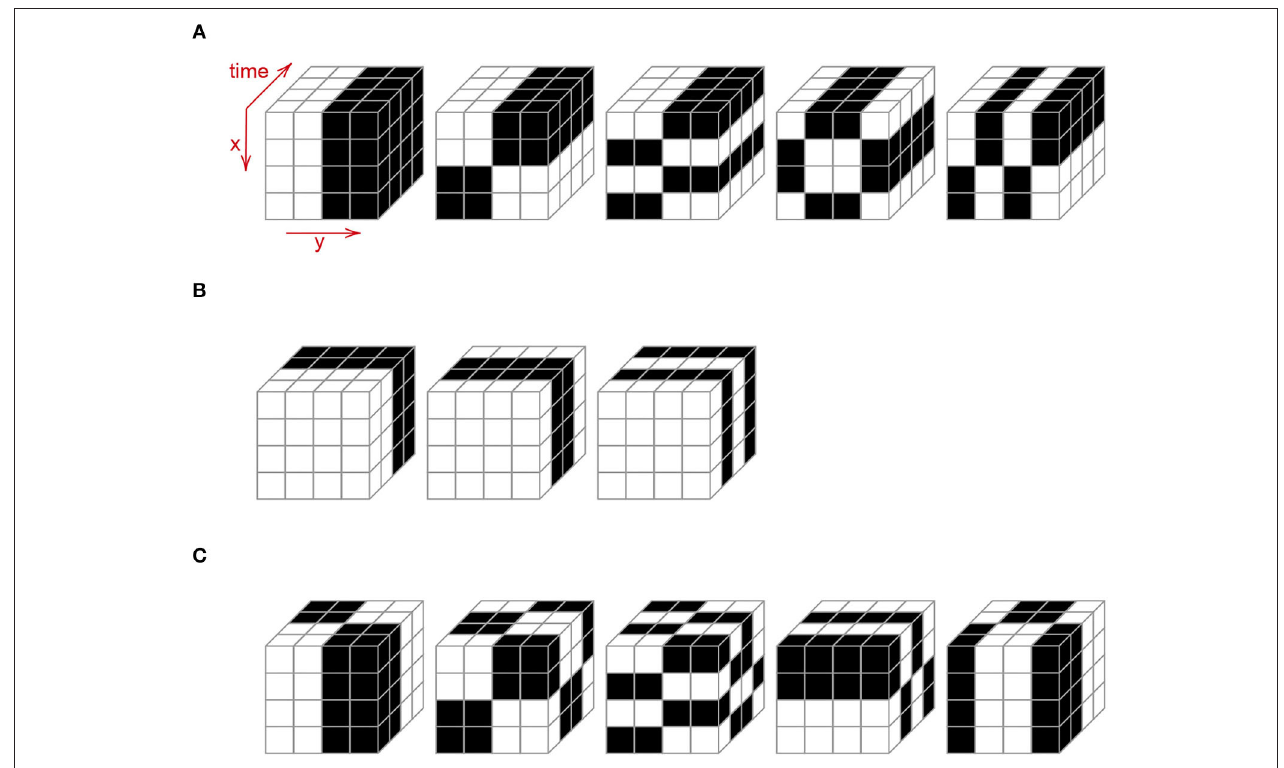
FIGURE 2 | Examples of (A) spatial, (B) temporal, and (C) spatio-temporal 3D